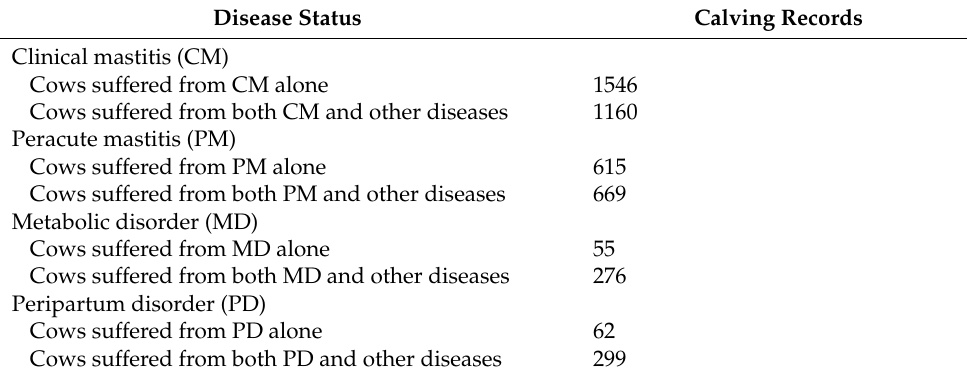
Table 1. The number of diagnoses of each disease 1 . Disease Status Calving Records Clinical mastitis (CM)